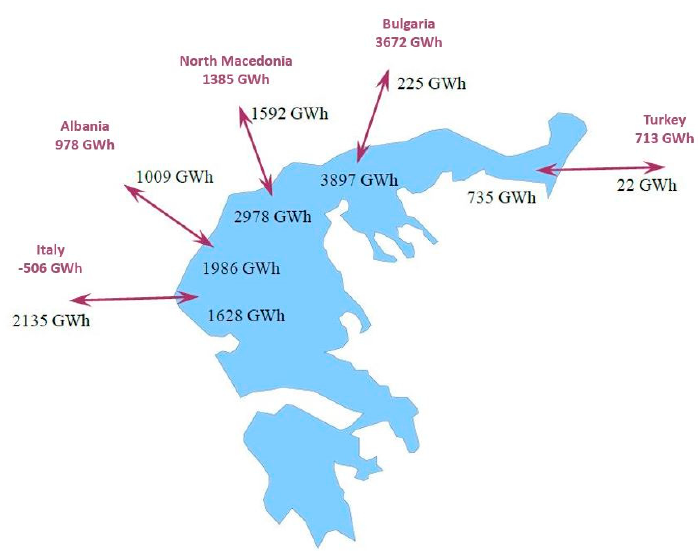
Figure 2. Greece’s energy imports and exports for 2018. The net position is marked with red (outcome of IPTO’s elaboration).